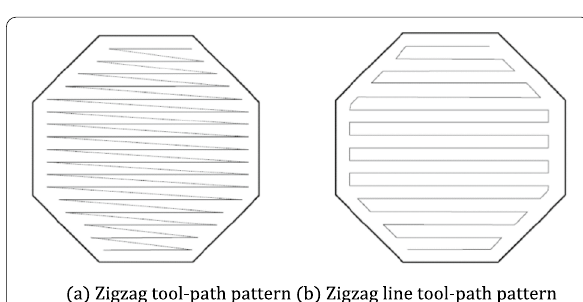
Fig. 11 Different types of direction-parallel tool-path patterns. Using the subsequent steps, convert the parallel tool-path lines from the one-way pattern to the zigzag tool-path filling pattern